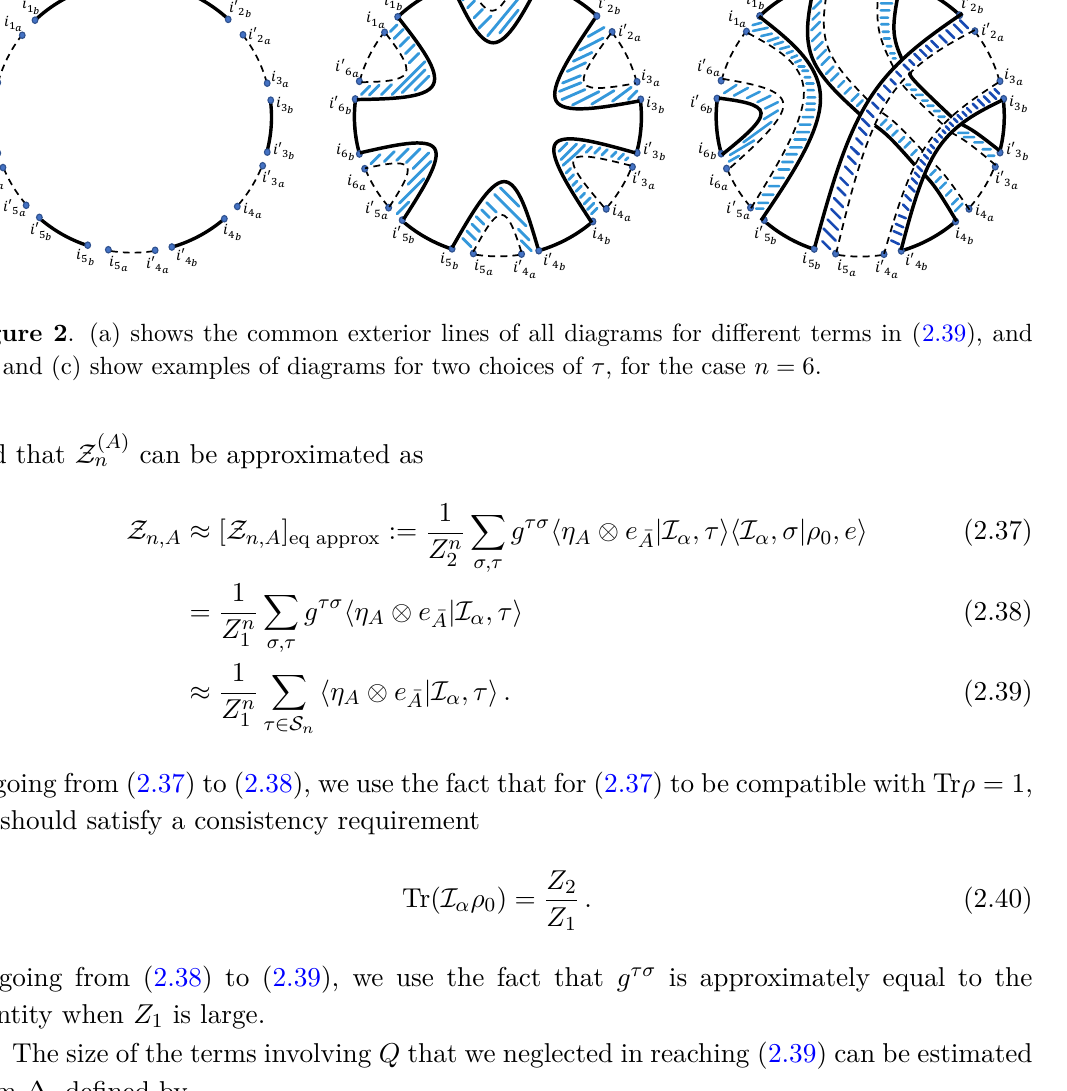
FIG. 2. “Boundary conditions” for each of the (2.38). Explain how to contract with